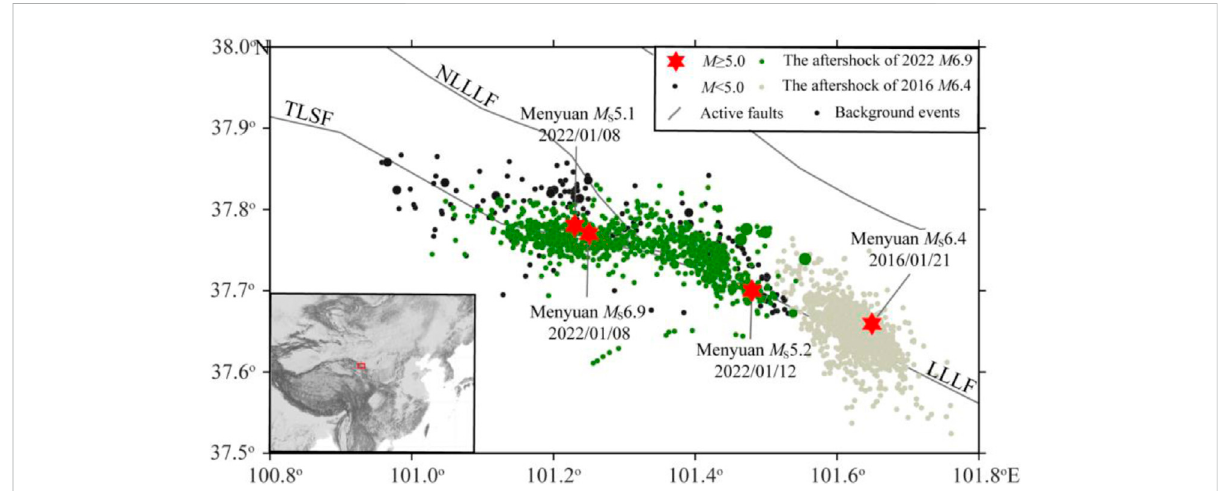
FIGURE 1 Spatial distribution of epicenters. The black dots represent background events before the Menyuan M S 6.9 since 1970. The gray dot represents the 2016 M S 6.4 Menyuan earthquake sequence, and the green dots represent the 2022 M S 6.9 Menyuan earthquake sequence. LLLF stands for Lenglongling fault, NTLSF is the north Lenglongling fault, and TLSF is the Tuolaishan